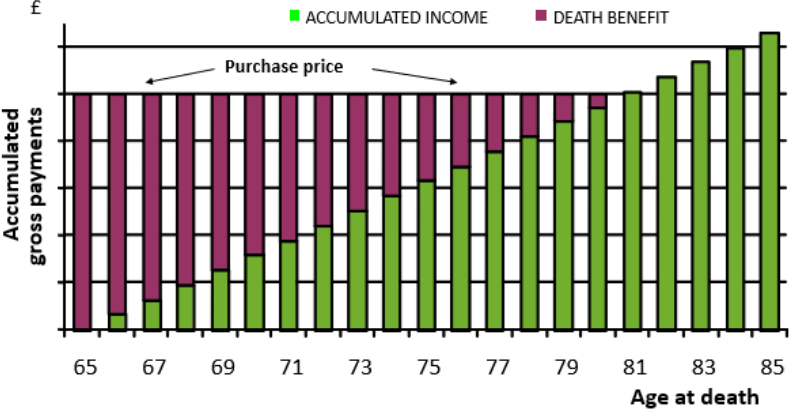
Figure 3. Death benefits with a money ‐ back annuity.